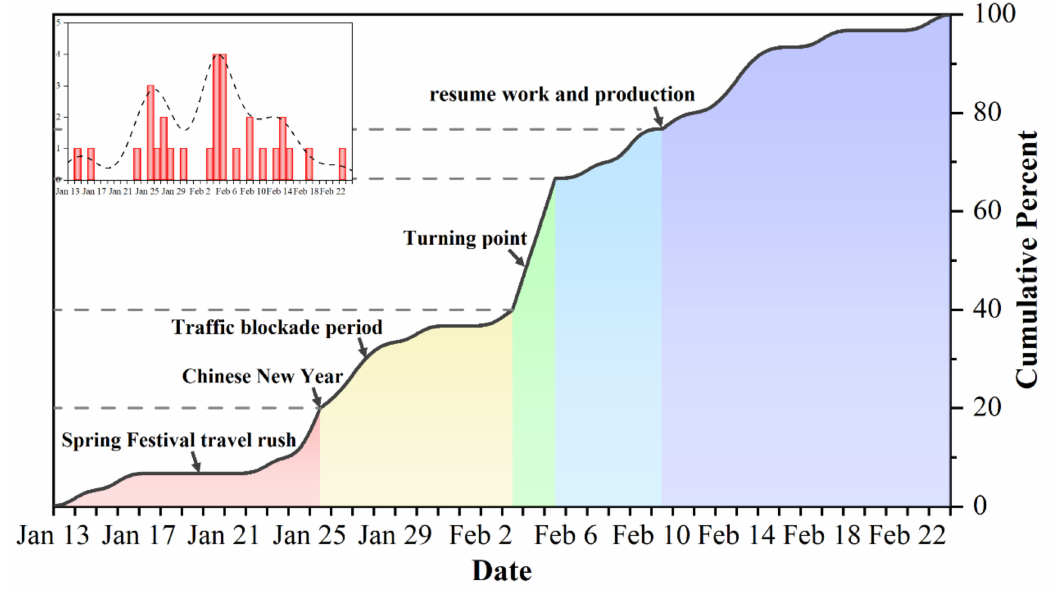
Figure 2. Development and stage definition of COVID-19 in the empirical area from 14 January to 23